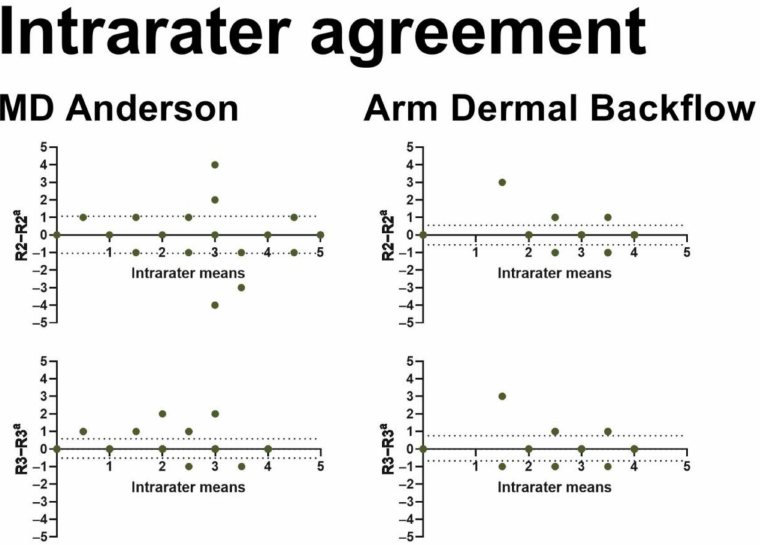
Figure 3. This figure shows Bland–Altman plots for intrarater agreements in MDA and ADB scales. The x-axis represents the mean intrarater stage (range: 0–5). The y-axis shows the difference in intrarater staging (range: − 5–5). The horizontal dotted lines denote the 95% confidence intervals for the limits of agreement. R2 = rater 2, R3 = rater 3. a = second